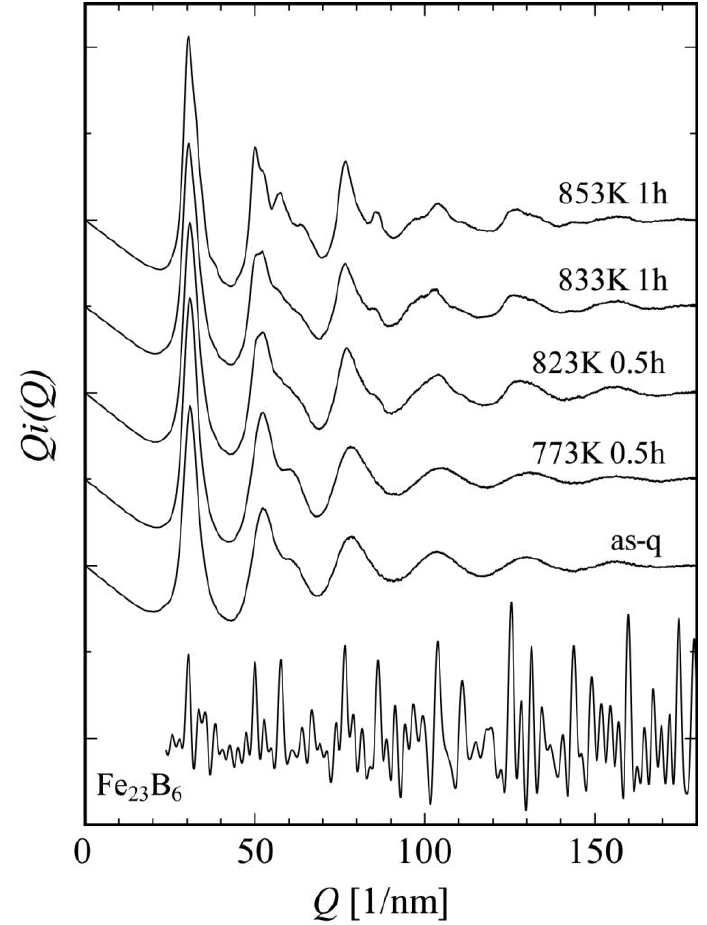
Co Nb Si B on 36 36 4 4 20 B 23 6